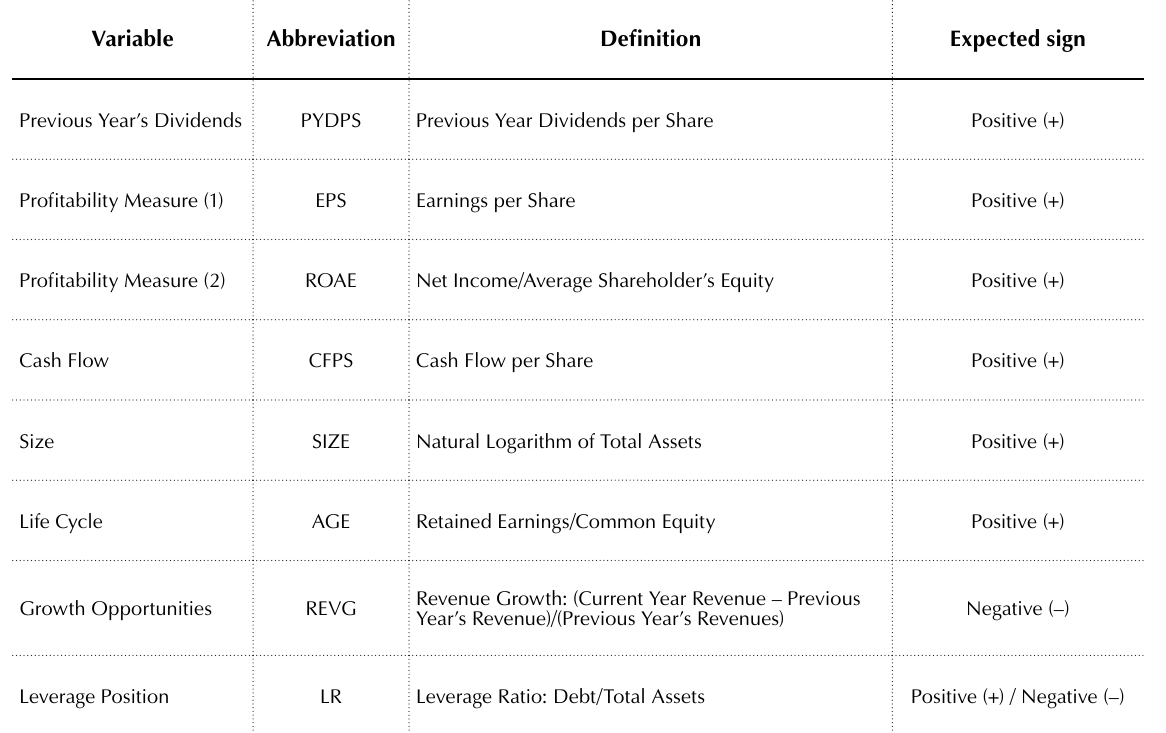
Table 1. Independent variables definitions and expected relationship with the dependent